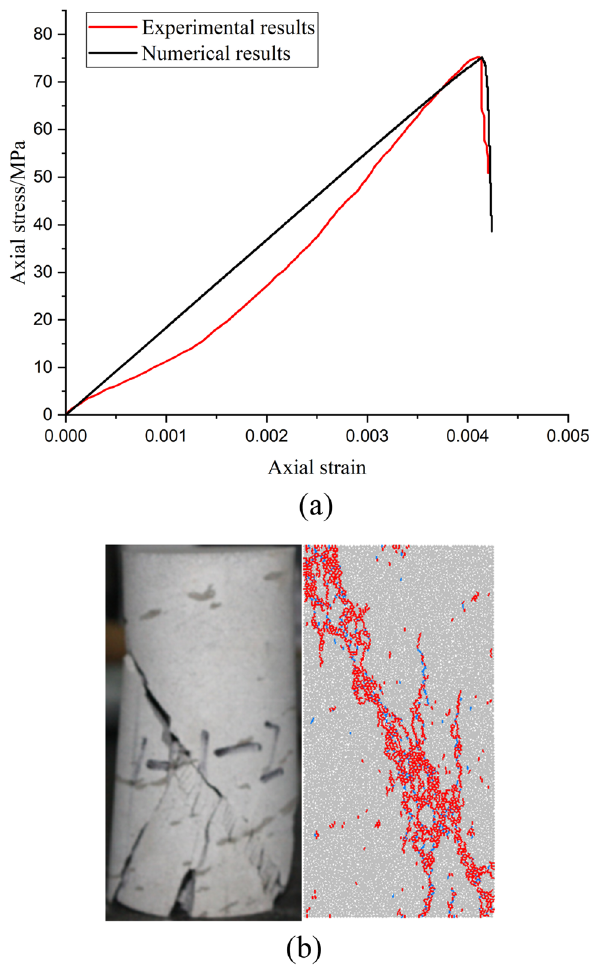
Figure 1: Stress – strain curves and damage surfaces of laboratory [ 24 ] : ( a ) stress – strain curve and ( b ) damage surfaces.